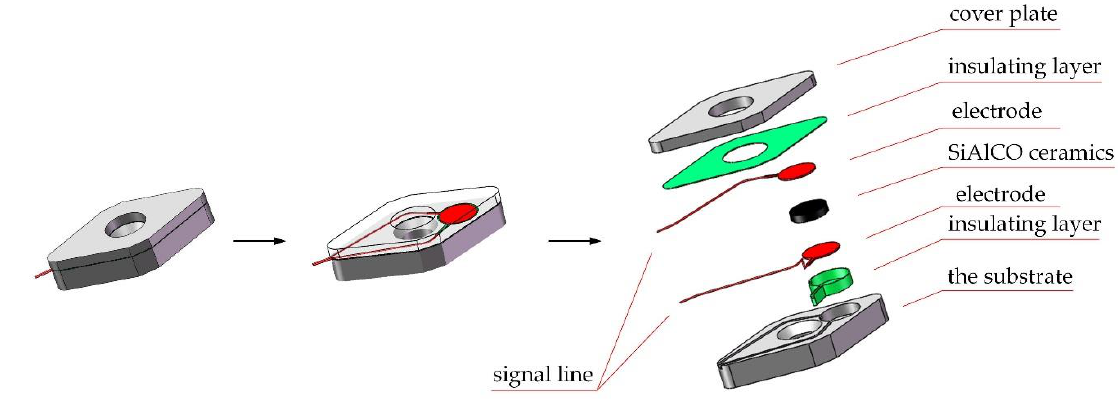
Figure 3. The structure of the cutting force.